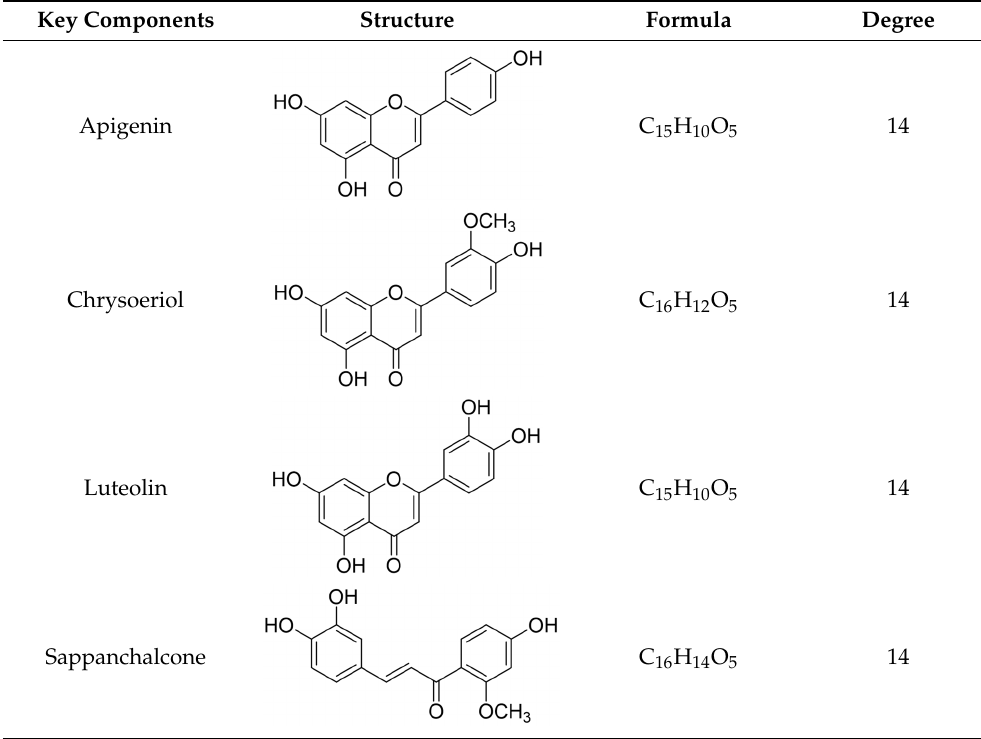
Table 3. List of the key components detected in Dangguisu-san using HPLC-Q-TOF-MS analysis.